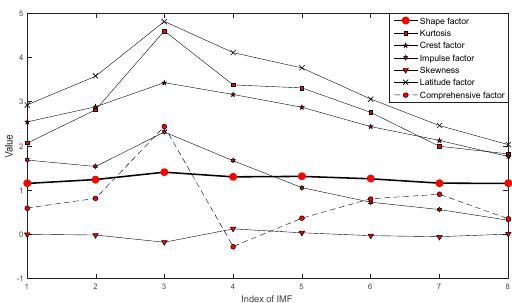
Sensors 2019 , 19 , x FOR PEER REVIEW Figure 14. Comprehensive factor and factor of single statistical method. Figure 14. Comprehensive factor and factor of single statistical method.